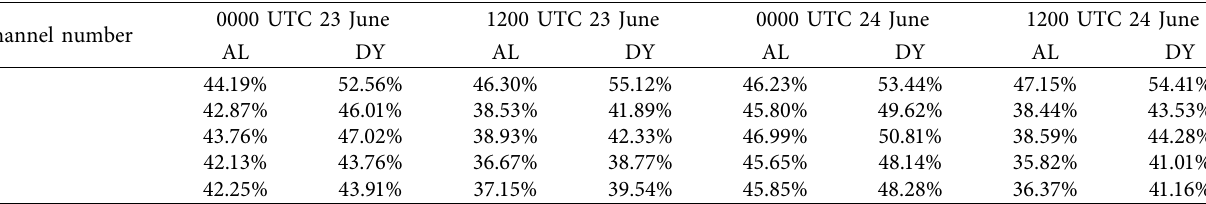
Table 3: The percentage of the used data for channels 11–15 at each analysis time.